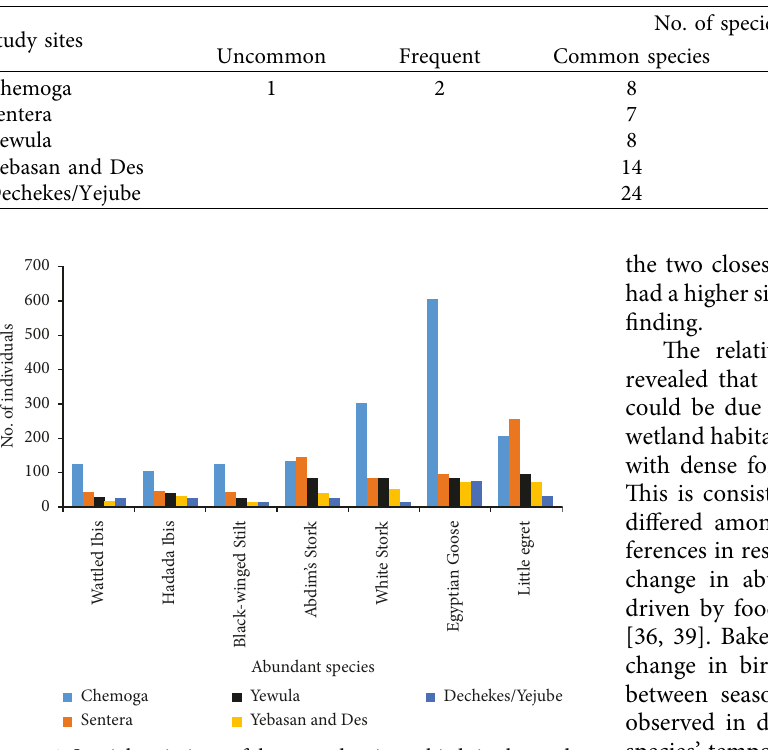
Figure 4: Spatial variations of the most dominant birds in the study